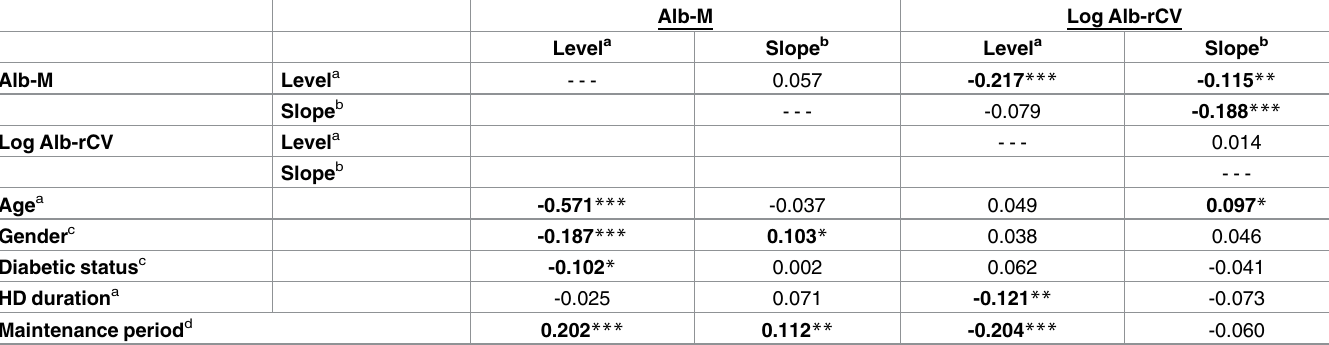
Table 1. Correlations among parameters of albumin dynamics and demographic factors during the maintenance